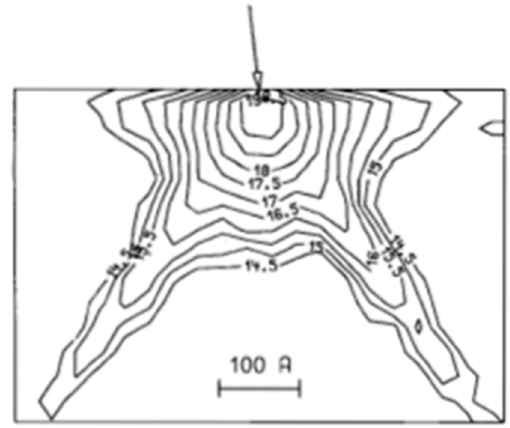
Figure 14. Boron concentration profile of point response by Monte Carlo simulation [25]. Wafer: (100); Ion: B + ; Energy: 0.5 keV; Dose: 1 × 10 15 cm − 2 ; Tilt: 7 ◦ ; Twist: 22 ◦ . The arrow denotes a point where B +